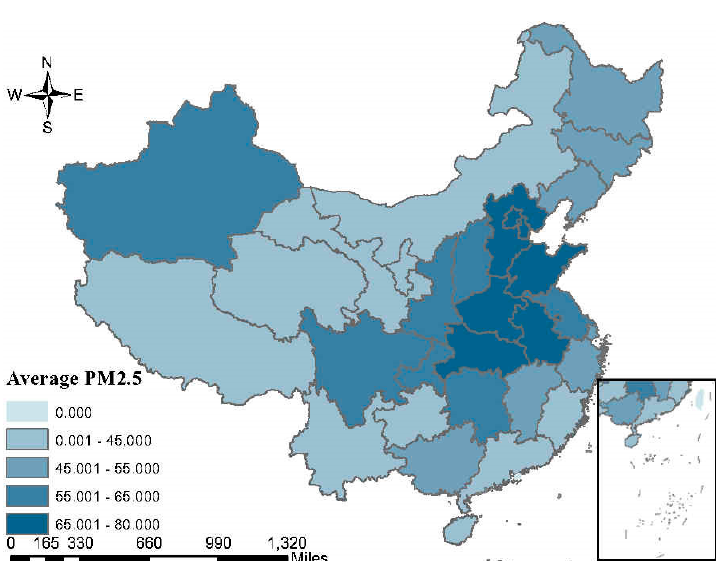
Figure 3. The spatial distribution of average annual PM2.5 index in China. Source: National Figure 3. ThespatialdistributionofaverageannualPM2.5indexinChina. Source: NationalMeteorological Meteorological Information Center of China, 2013–2018. Information Center of China,